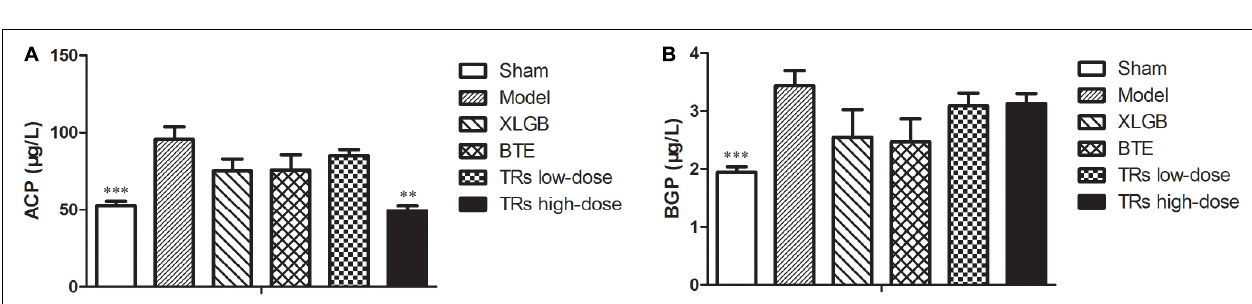
FIGURE 3 | The effect of black tea extract (BTE) and thearubigins (TRs) on the serum biochemical indices in ovariectomized (OVX) rats. The levels of (A) acid phosphatase (ACP) and (B) bone gla protein (BGP) for the different treatment groups. All data are presented as mean ± SEM ( n = 10). “Independent Samples T-Test” and “One way ANOVA” were used for the comparison of sham vs model group and model vs treatment groups using pooled variance, respectively. ∗∗ p < 0.01 and ∗∗∗ p < 0.001 vs model